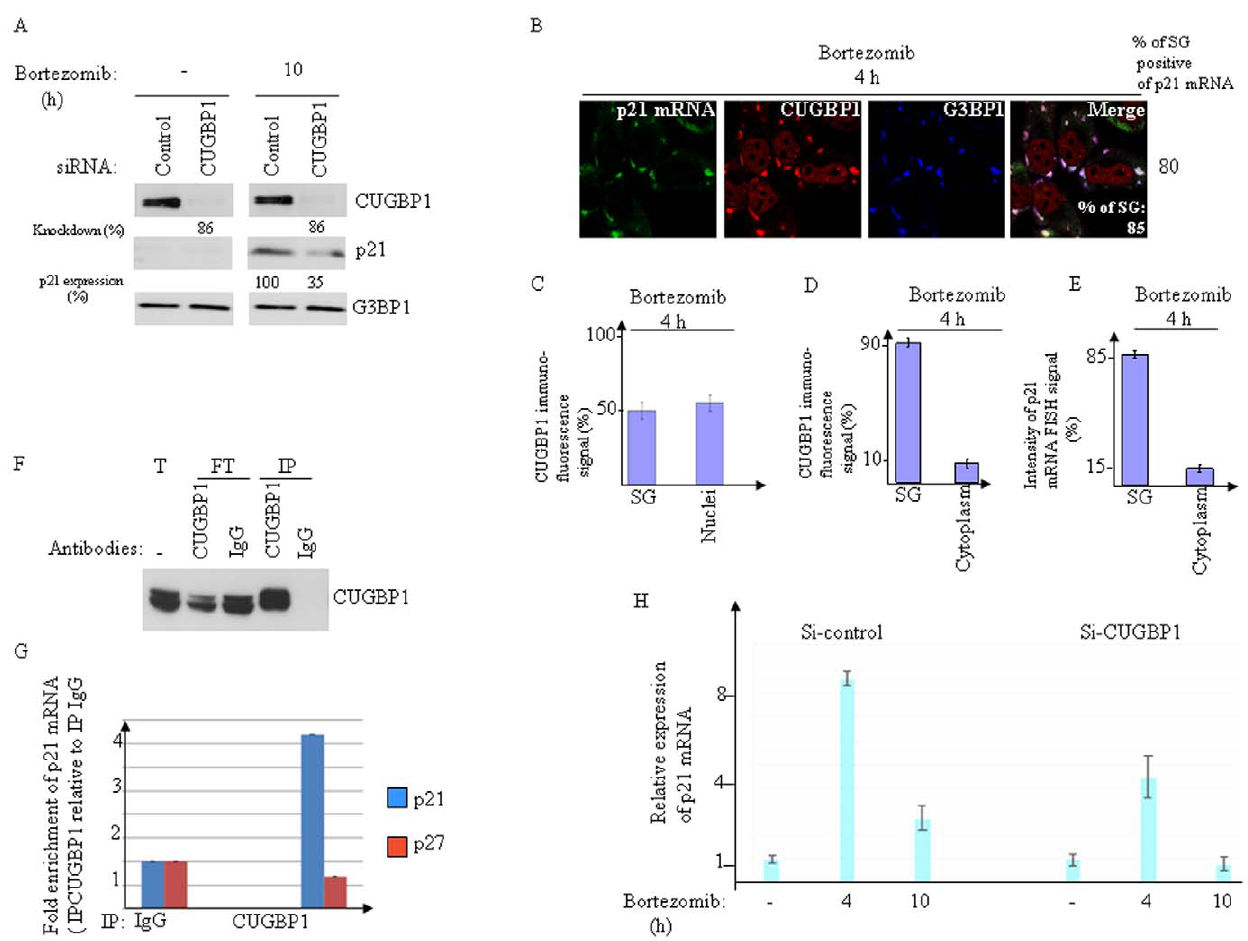
Figure 3. CUGBP1 binds to p21 mRNA and promotes its accumulation and expression upon bortezomib treatment. (A–D) Seventy- two hours following transfection with CUGBP1, or control siRNAs, HeLa cells were treated with bortezomib (2 m M) for either 10 h (A) or 4 h (B). (A) Protein extracts were prepared and analyzed by western blot to detect CUGBP1, p21, and G3BP1 proteins (loading standards) using the appropriate antibodies. The percentages of CUGBP1 knockdown and p21 expression were determined by quantitation of the signal on films by densitometry using Adobe Photoshop as described in Figure 1C. Shown are typical results of three experiments. (B–D) p21 mRNA is quantitatively recruited into SG where it co-localizes with CUGBP1. (B) Cells were processed for FISH to detect p21 mRNA coupled to immunofluorescence to visualize SG using antibodies against CUGBP1 and G3BP1. The percentage of SG ( . 3 granules/cell) is indicated at the bottom of the right panel. The percentage of cells harboring SG positives for p21 mRNA is also indicated on the right of the figure. Shown are typical results from five different fields and three different experiments containing a total of more than 1000 cells. (C–D) Densitometry quantification of CUGBP1 immunofluorescence signal in SG versus nuclei (C) and in SG versus the cytoplasm (D) using Adobe Photoshop software as described in Figure 1. (E) Densitometry quantification of p21 mRNA FISH signal was done as described in Figure 2. (F–G) HeLa cells were treated with bortezomib for 4 h and their extracts were used to immunoprecipitate CUGBP1 with anti-CUGBP1 antibodies and with IgG as a control. IP: Immunoprecipitate; FT: flow-through following immunoprecipitation; Total: the input used for immunoprecipitation. (F) Proteins were analyzed by western blot for CUGBP1 immunoprecipiation. (G) mRNAs were isolated from each immunoprecipitate and quantified by qRT-PCR. The amounts of p21 mRNA and p27 mRNA (as control) were normalized against GAPDH mRNA. (H) HeLa cells were treated with CUGBP1-specific siRNA, or with control (non-specific) siRNA as described above, incubated with 2 m M bortezomib for either 4 or 10 h, lysed, and their total RNA isolated and analyzed for p21 mRNA levels by qRT-PCR. The amount of p21 mRNA was normalized against that of GAPDH mRNA as described in Figure 2.